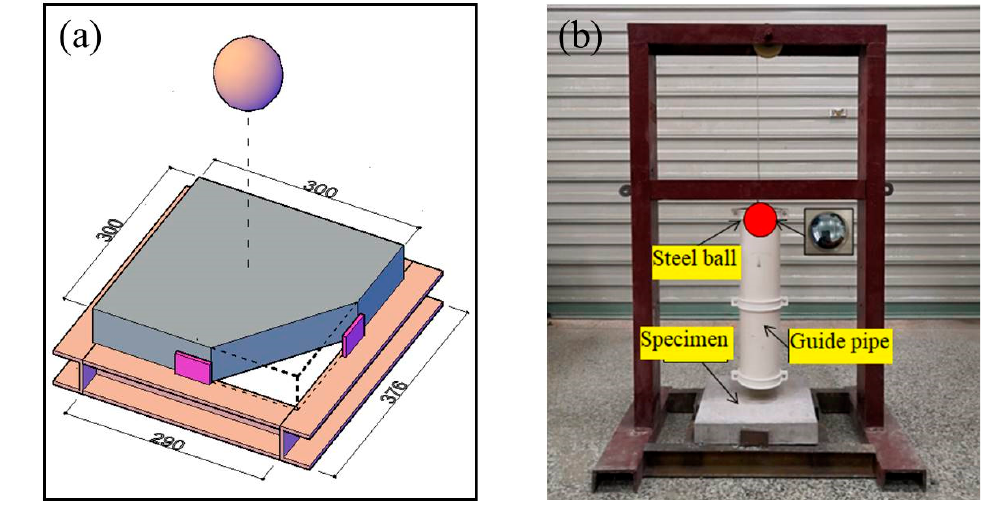
Figure 2. Test device of drop-weight impact resistance: ( a ) design diagram; ( b ) physical diagram.